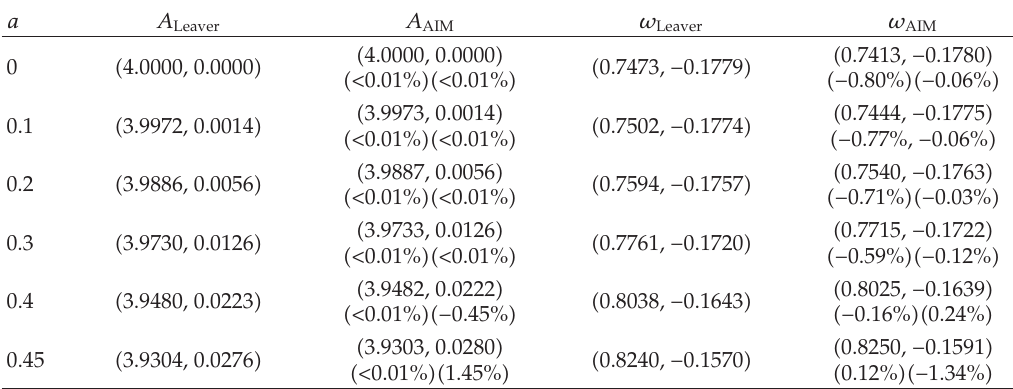
Table 11: Spin-2 angular separation constants and Kerr gravitational quasinormal frequencies for the fundamental mode corresponding to l (cid:8) 2 and m (cid:8) 0 compared with the CFM (cid:5) 6 (cid:6) (cid:2) M (cid:8) 1 / 2 (cid:3)